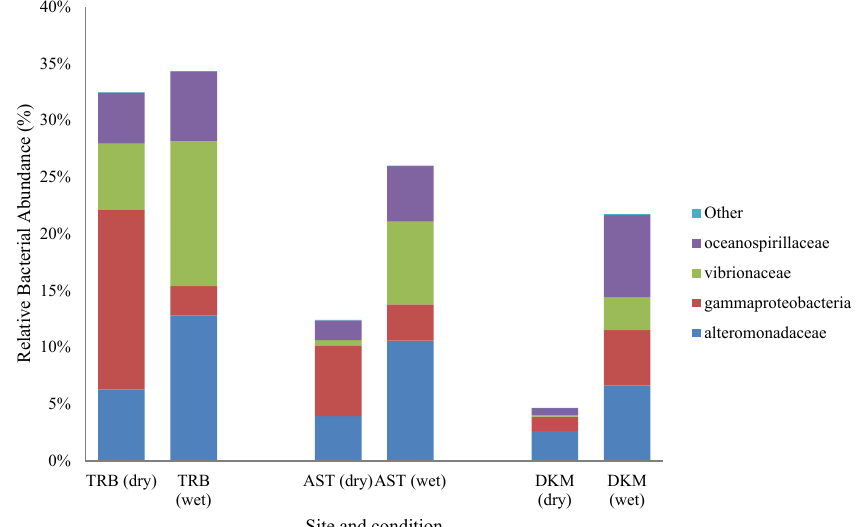
Fig. 3: Relative bacterial abundance of gammaproteobacteria families of samples taken from Newtown Creek on dry (09/08/16) and wet (09/15/17) days from TRB, AST and DKM sites.